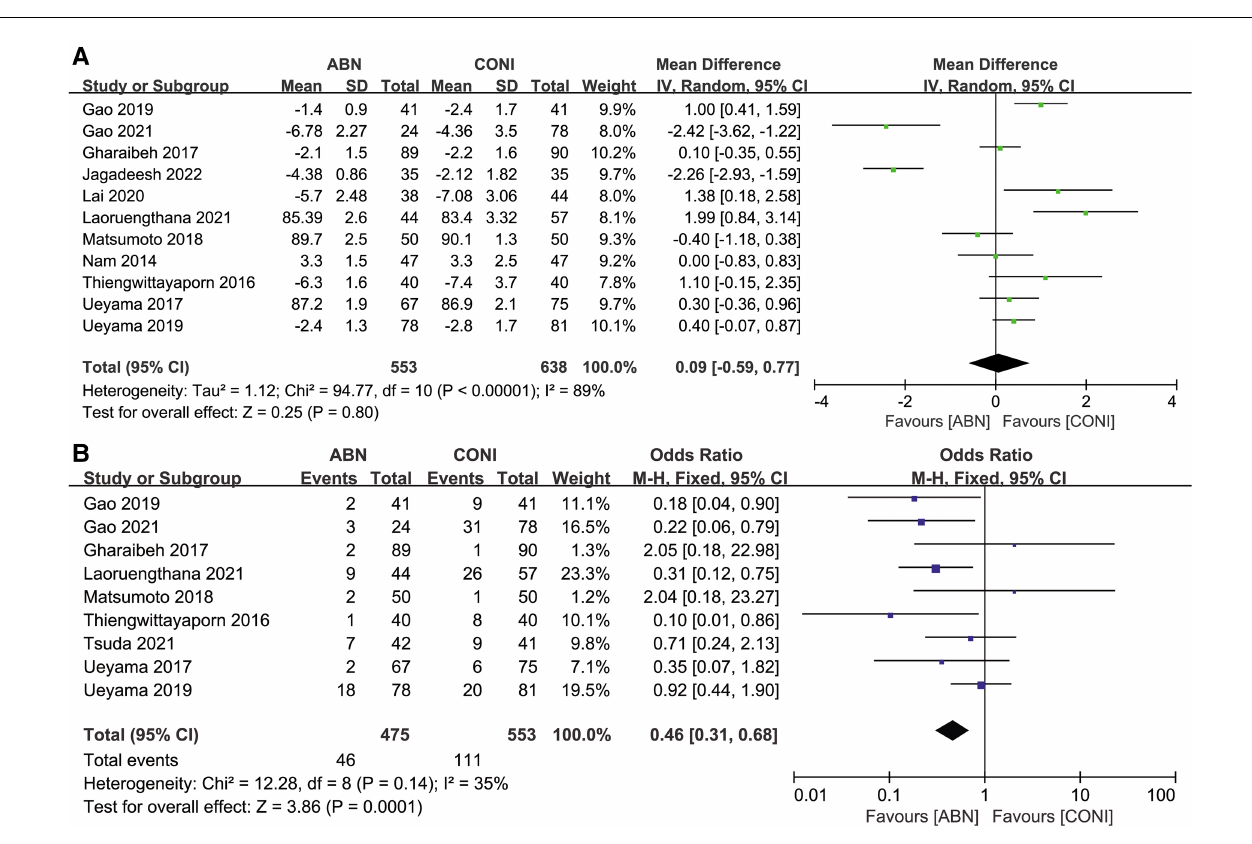
FIGURE 10 Forest plot of sagittal tibial angle (STA). ( A ) And STA outliers ( B ) between accelerometer-based navigation (ABN) system and conventional instrumentation